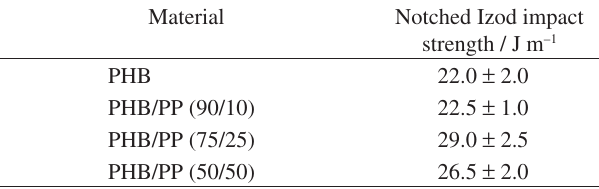
Table 5. Notched Izod impact strength values for PHB and PHB/PP blends.